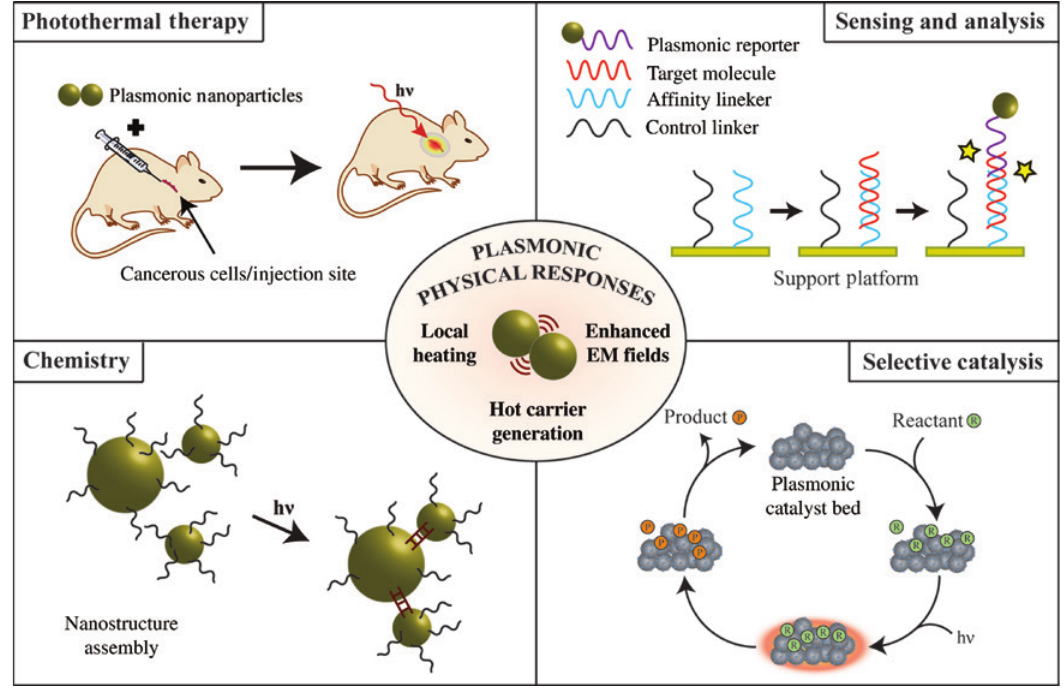
Figure 1: Present-day applications for plasmonic materials. (Top left) Plasmonic nanoparticles have been employed to target cancerous cells within live organisms. Once photoexcited, the plasmonic energy is intentionally converted into a thermal energy to annihilate the targeted cells. (Top right) Sensing platforms constructed with plasmonic materials are used to detect specific analytes at an ultralow concentration. (Bottom left) Nanolevel architectural design can be achieved by inducing chemical reactions that link two or more individual nanoparticles to assemble a new plasmonic structure. (Bottom right) Plasmonic nanostructures are capable of mediating highly selective catalytic